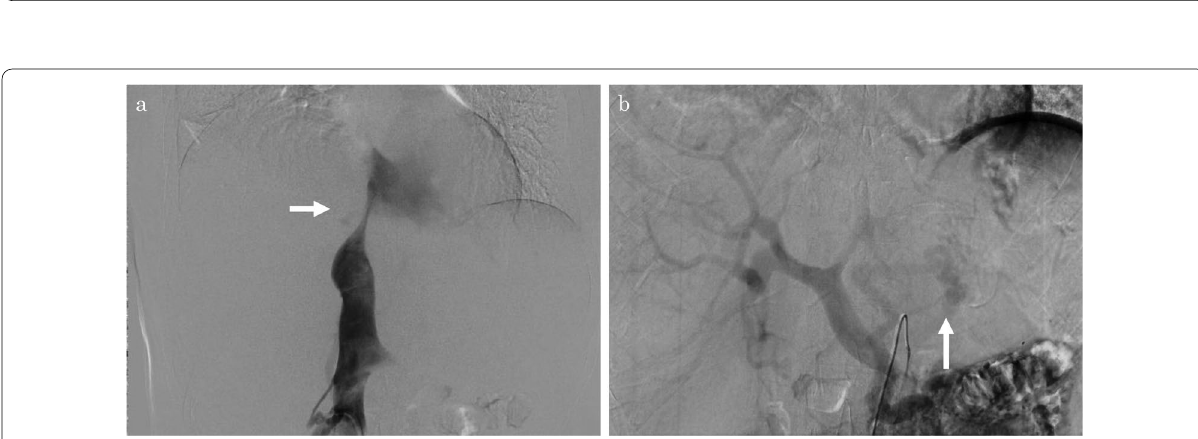
Fig. 3 Preoperative angiography. Angiography confirms stenosis of the inferior vena cava (IVC) preoperatively ( a ). Angiography of the superior mesenteric artery reveals a left gastric vein–left renal vein shunt, although the portal veins enhanced the antegrade flow ( b